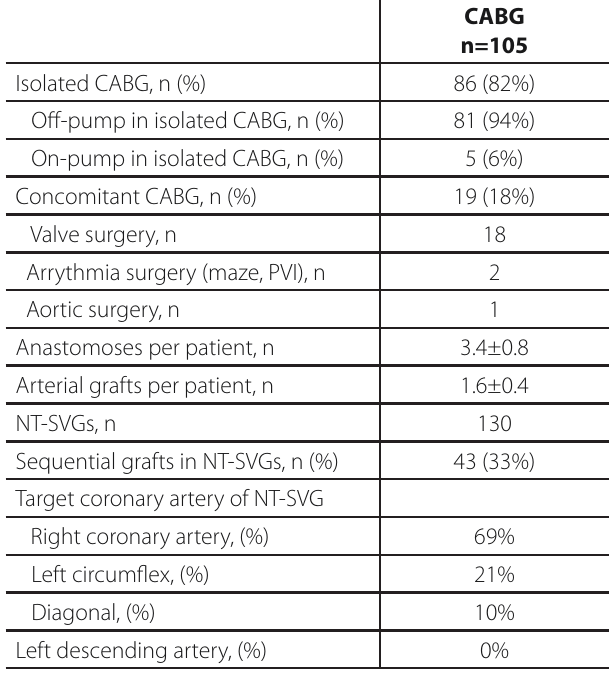
Table 2. Operative data.